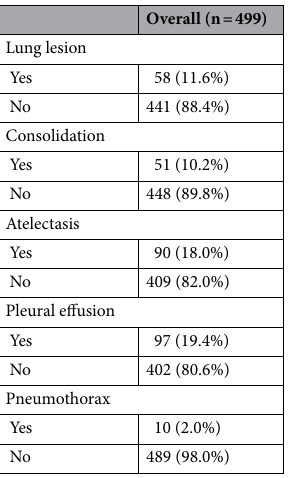
Table 2. Total number of verified findings on all analyzed radiographs.